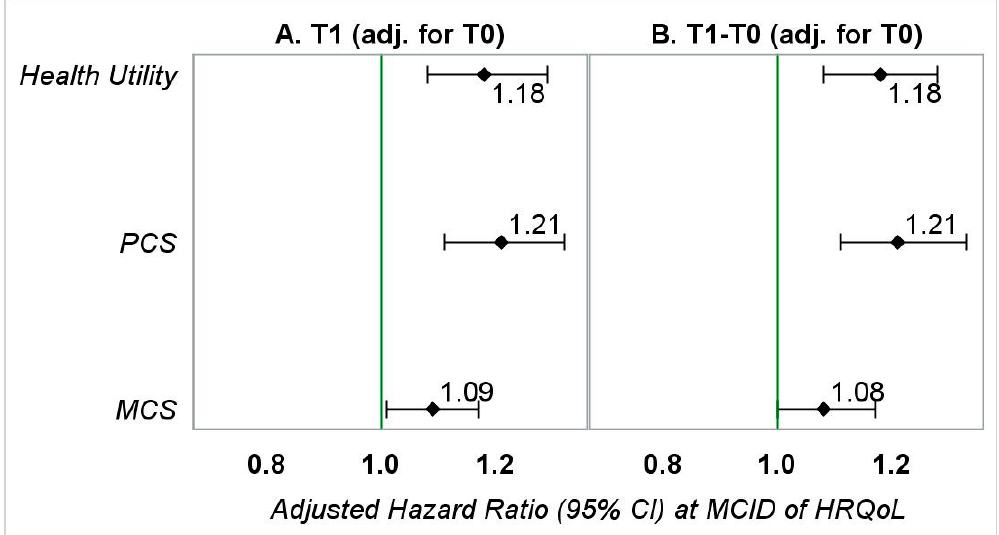
Figure 3. Adjusted hazard ratios (95% CI) representing the association between HRQoL (at MCID) and OS in patients with kidney cancer—sensitivity analyses I. PCS—physical component summary; MCS—mental component summary. ( A ) Hazard ratios represent the association between follow-up HRQoL (0.03-point or 3-point reduction) and overall survival adjusted for gender, race, education (T1), marital status (T1), annual household income (T1), smoking status (T1), geographic region, number of comorbid conditions (T1), age at diagnosis, stage of kidney cancer at diagnosis, tumor grade, treatment type, months between diagnosis of kidney cancer and the T1 survey, and baseline HRQoL. ( B ) Hazard ratios represent the association between change in HRQoL (0.03-point or 3-point reduction) from baseline to follow-up and overall survival adjusted for gender, race, education (T1), marital status (T1), annual household income (T1), smoking status (T1), geographic region, number of comorbid conditions (T1), age at diagnosis, stage of kidney cancer at diagnosis, tumor grade, treatment type, months between the T0 survey and kidney cancer diagnosis, months between diagnosis of kidney cancer and the T1 survey, and baseline